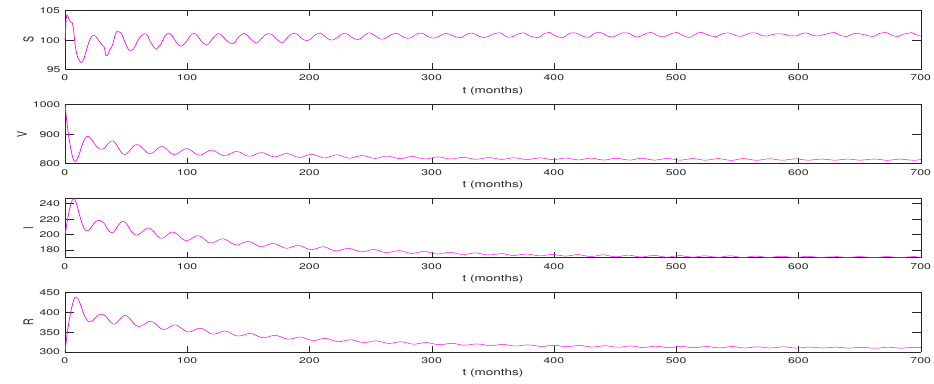
Figure 13. τ 2 ∗ = 32, τ 1 ∗ = 6, equilibrium E 2